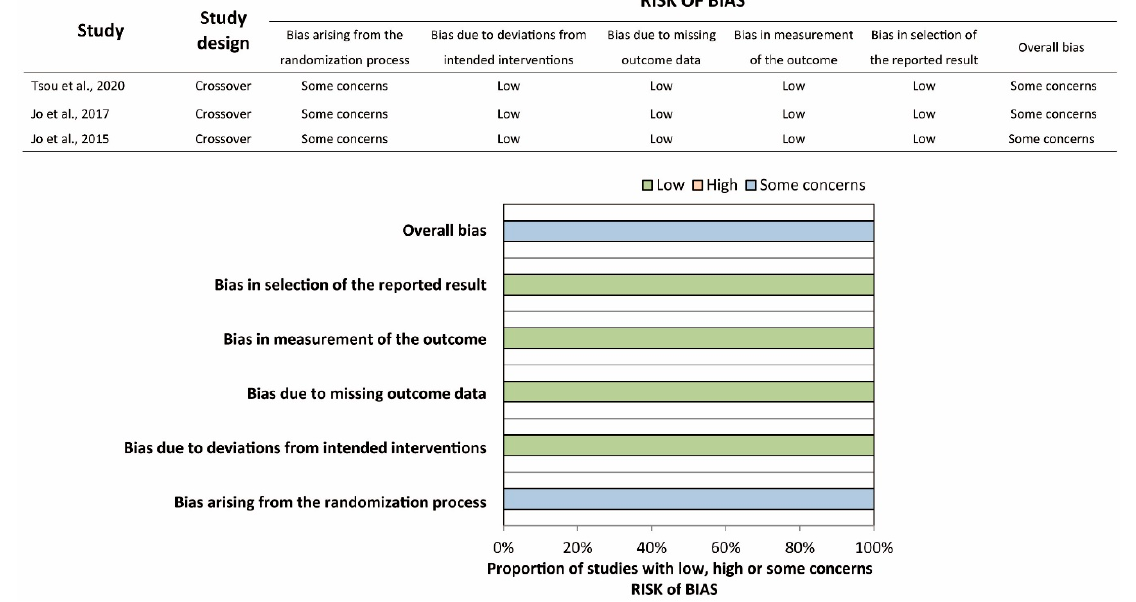
Figure 3. Risk-of-bias summary and graph of proportion of complete chest recoil.